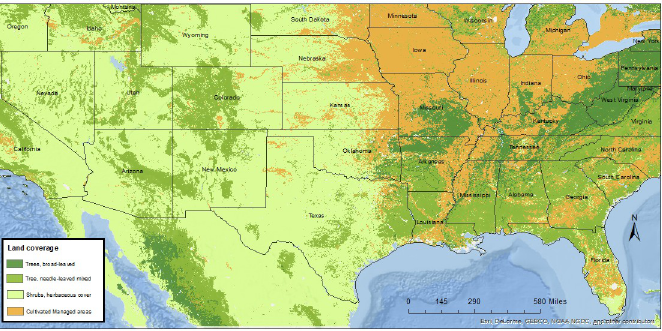
Fig 1. Land coveragerastercreatedusing ArcMap 10.2.2. The land coverageraster was obtained from the Global Land Cover 2000 Project (GLC 2000, [12]), coordinated and implemented by the Joint Research Centre (European